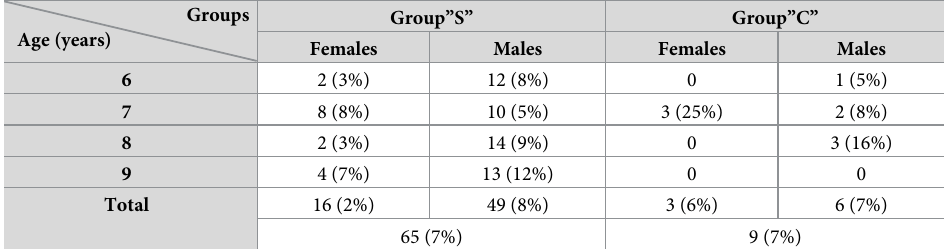
Table 2. Percentage left-handedness distribution in both the study group and the control group, by